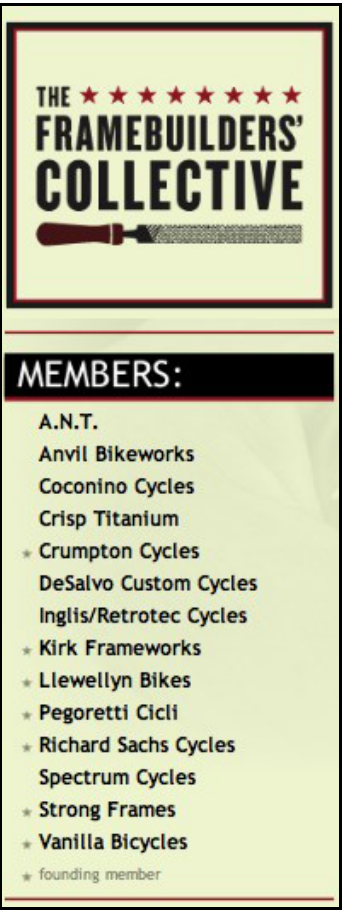
Figure 1: The Framebuilders